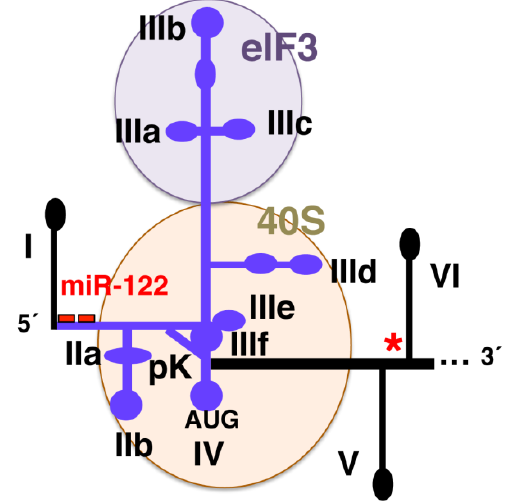
Figure 2. Schematic representation of the Hepatitis C virus (HCV) internal ribosome entry site (IRES) element and surrounding stem-loops. The IRES domains II, III, and IV, with stem-loops IIab and IIIabcdef, the pseudoknot (Pk), as well as the location of the initiator AUG codon in the loop of domain IV are depicted. The interaction sites of eIF3 and the 40S ribosomal subunit within the IRES element are highlighted. Domain I (involved in RNA replication) as well as the binding sites of miR-122 are depicted by a hairpin and red bars, respectively. A red asterisk in stem-loop VI depicts a sequence potentially annealing with the target region of miR-122, proposed to lock the IRES element in a closed